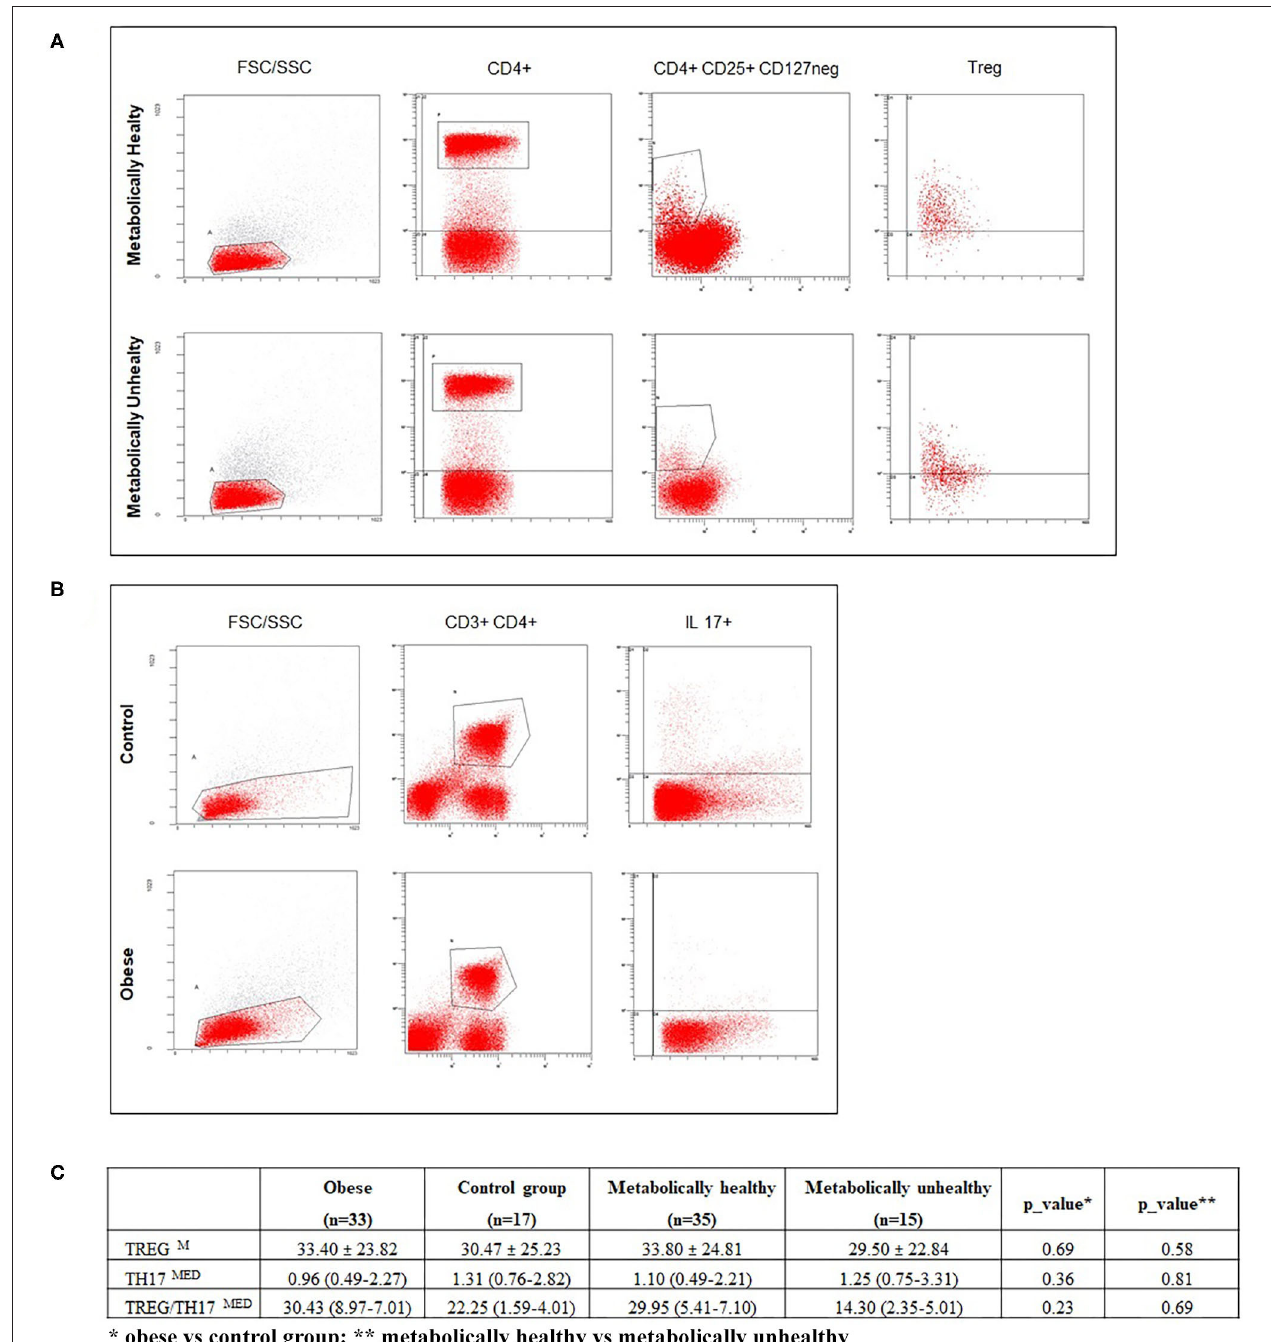
FIGURE 1 | (A,B) respectively, show representative flow cytometry analyses of Treg and Th17 subpopulations. (C) reports percentages of Treg, Th17 cells, and the Treg/Th17 ratio in enrolled subjects, according to BMI and metabolic status. Data are expressed as the mean ± SD (M) or median and IQR (MED). A p ≤ 0.05 was considered